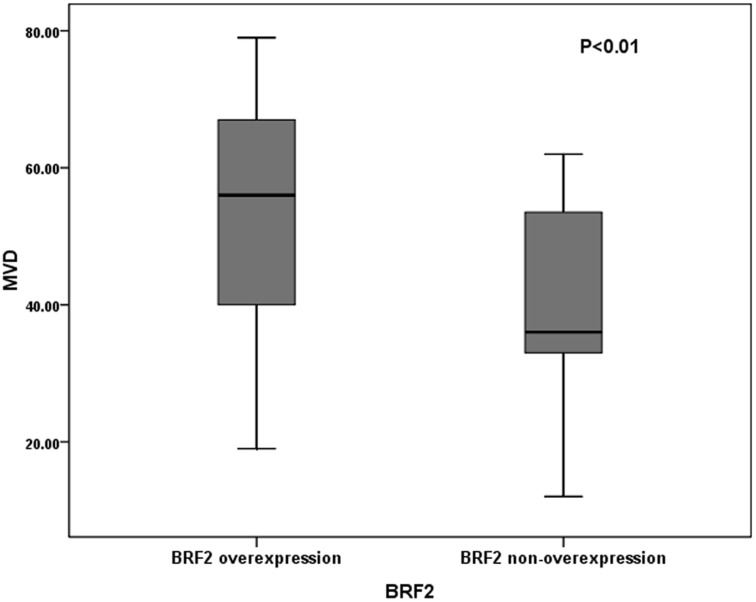
Intratumoral microvessel density (MVD) in relation to BRF2 protein immunoreactivity.Mann–WhitneyUtest demonstrated that tumors with BRF2 protein high expression showed significantly higher intratumoral MVD than tumors with BRF2 protein low expression (P<0.001).